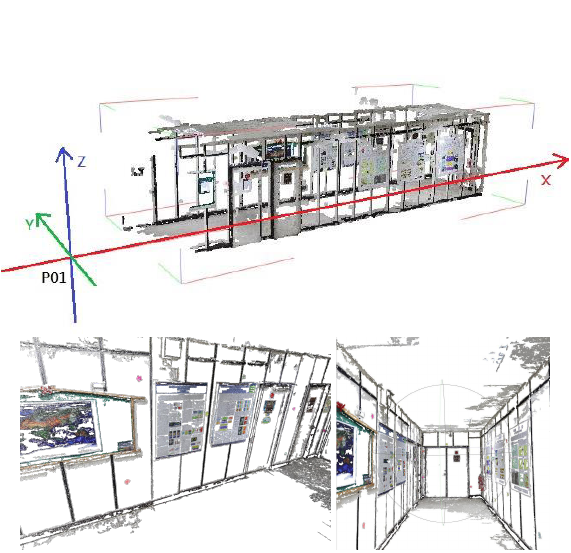
Figure 3: Point cloud generated from DSLR and Kinect color images